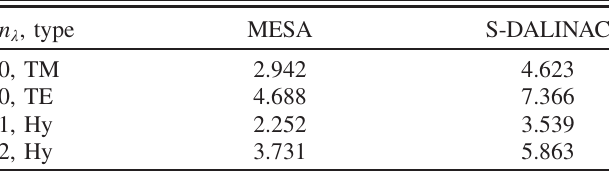
TABLE III. Cutoff frequencies of the beampipe near cavities (GHz).